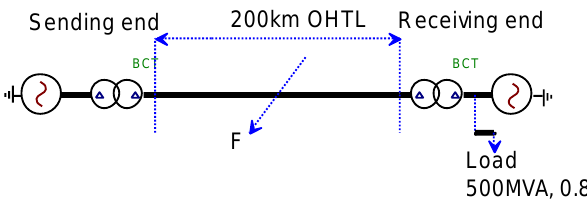
Figure 1. A 500 kV transmission line in Egypt with a 200 km-long line.